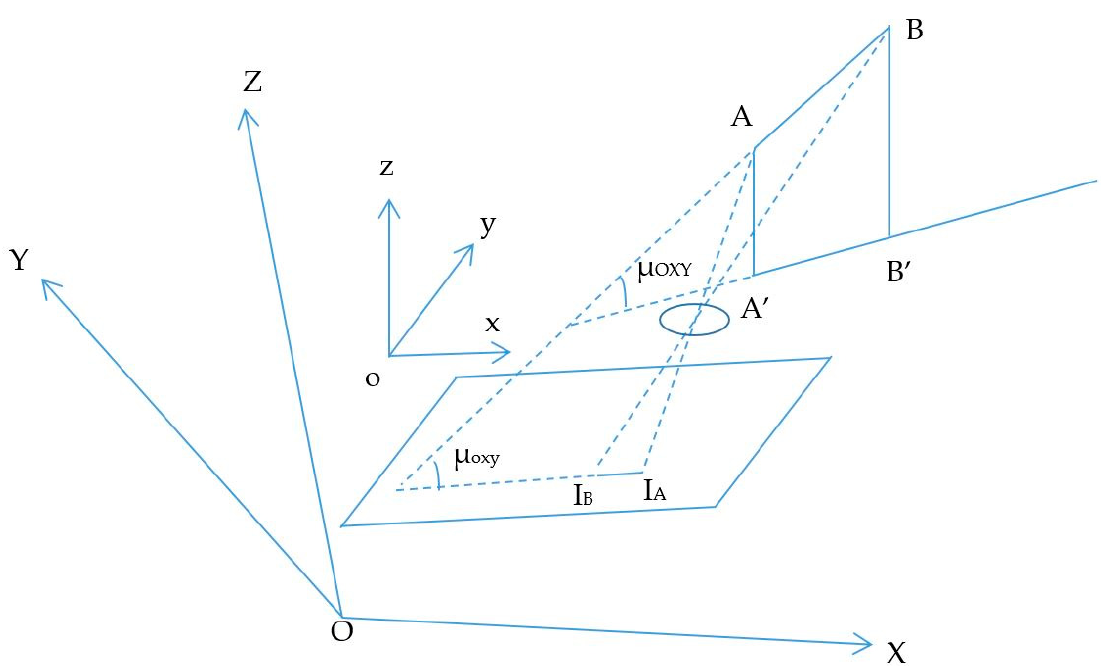
Figure 5. Image of reference points in the image sensor plane.